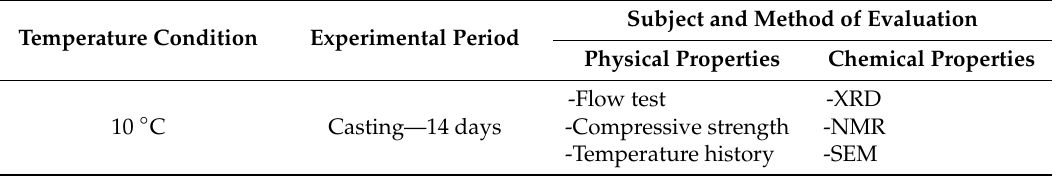
Table 4. Experimental conditions and evaluation